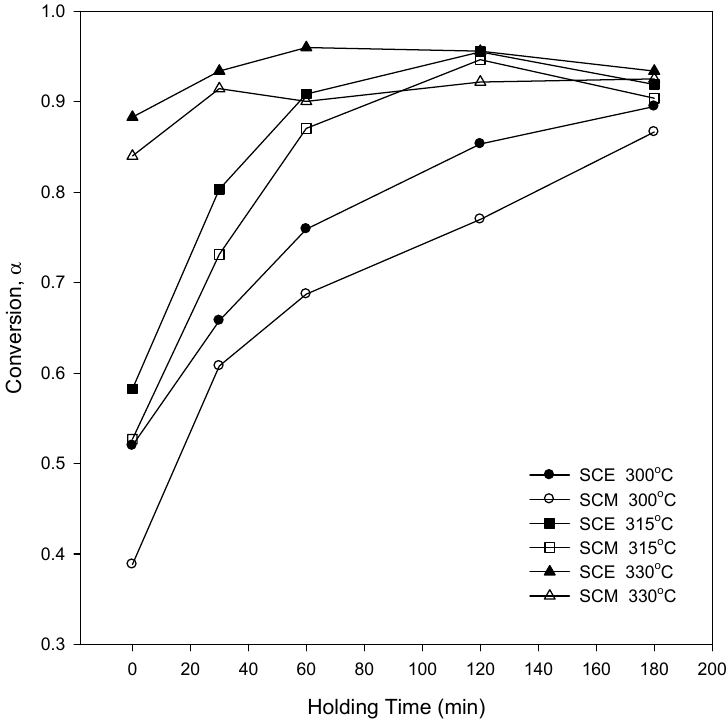
Figure 8. Percentage conversion at various reaction temperatures using SCM and SCE.